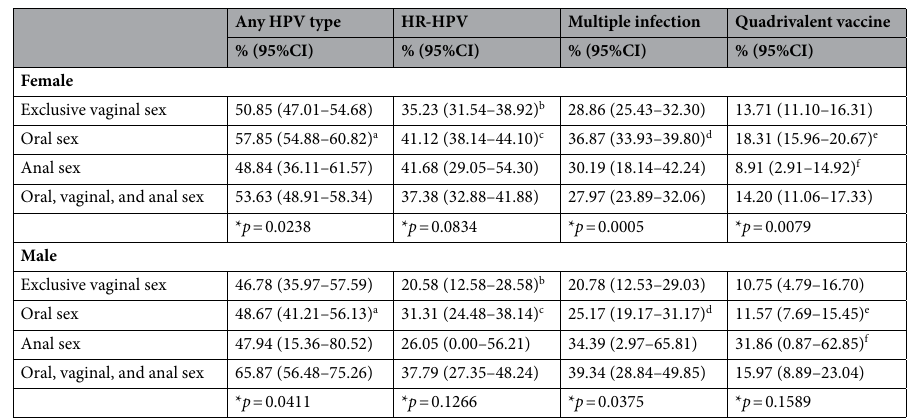
Table 3. Prevalence of genital, high-risk, multiple HPV infections, and vaccine types with 95% confidence interval (CI), according to types of sex practiced and by gender. * P value indicates whether there is a difference in the prevalence of HPV between the different types of sex practiced, in each stratum (for men and women). a,b,c,d,e,f Indicates that there is a significant difference in the prevalence of HPV between men and women for each type of sex practiced.